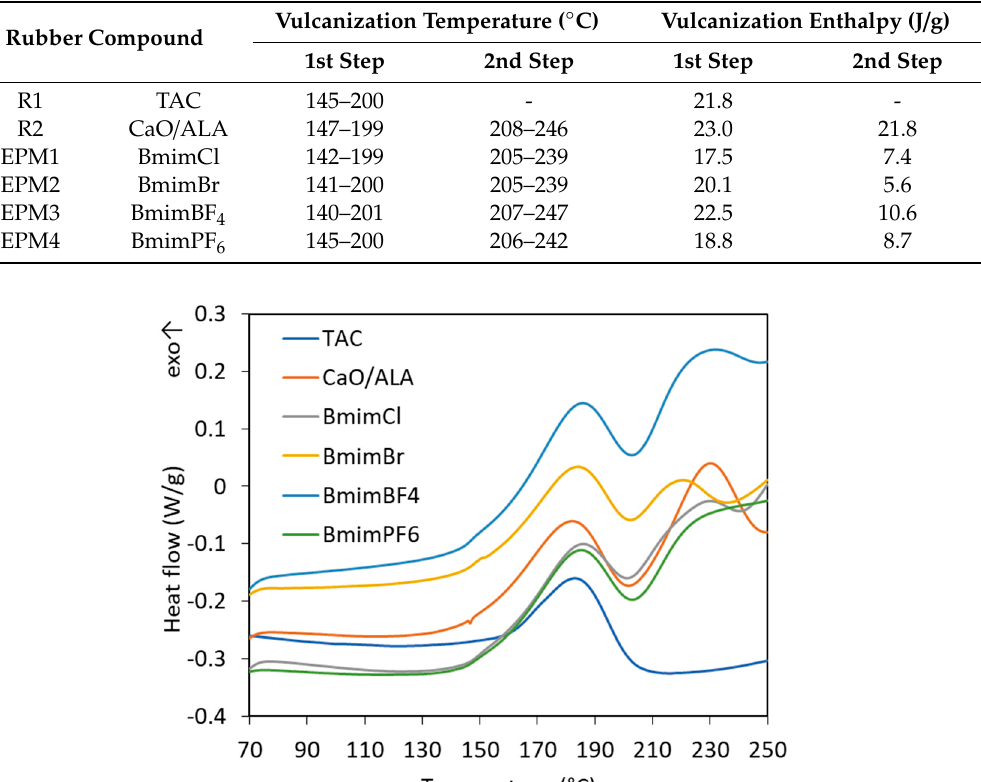
Table 7. Temperature range and enthalpy ( Δ H) of vulcanization measured by differential scanning calorimetry (DSC) for silica-filled EPM compounds (standard deviations: temperature ±3 ◦ C; ∆ H ± 2.2 J/g).